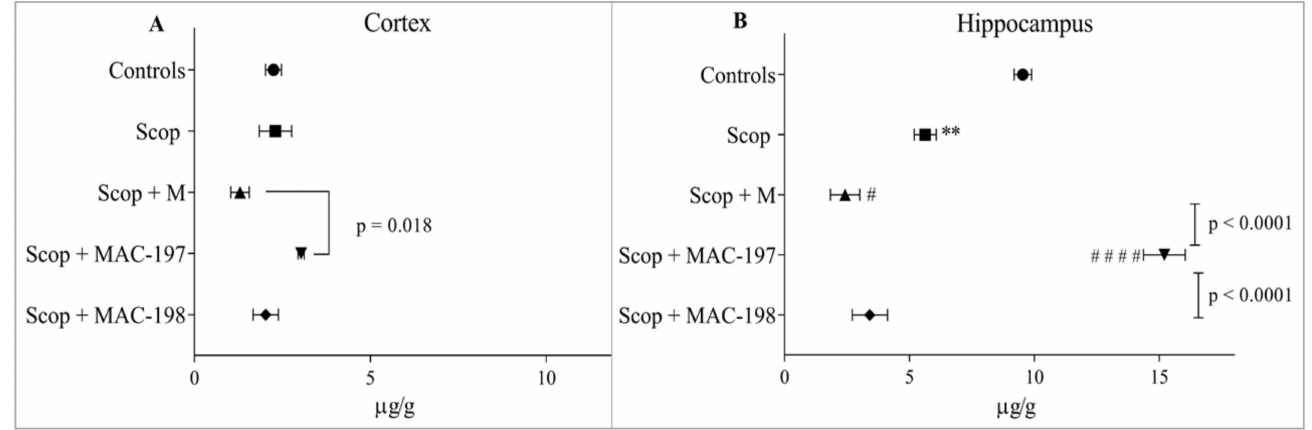
Figure 7. Effects of MAC-197 and MAC-198 on brain NA levels in cortex ( A ) and hippocampus ( B ) in rats with scopolamine-induced dementia; M (40 mg/kg) was used as a referent; data are expressed as the mean ± SEM ( n = 5). ** p < 0.01 vs. Controls; # p < 0.05, # # # # p < 0.0001 vs. Scop